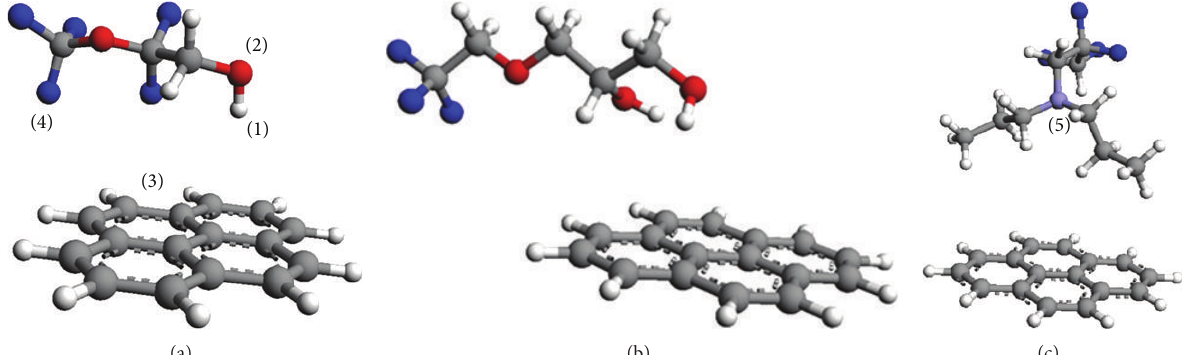
Figure 8: (a) Z-dol-graphene equilibrium geometry, (b) Z-tetraol-graphene equilibrium geometry, and (c) DDPA-graphene equilibrium geometry. Red = oxygen, violet = nitrogen, blue = fluorine, grey = carbon, and white = hydrogen.